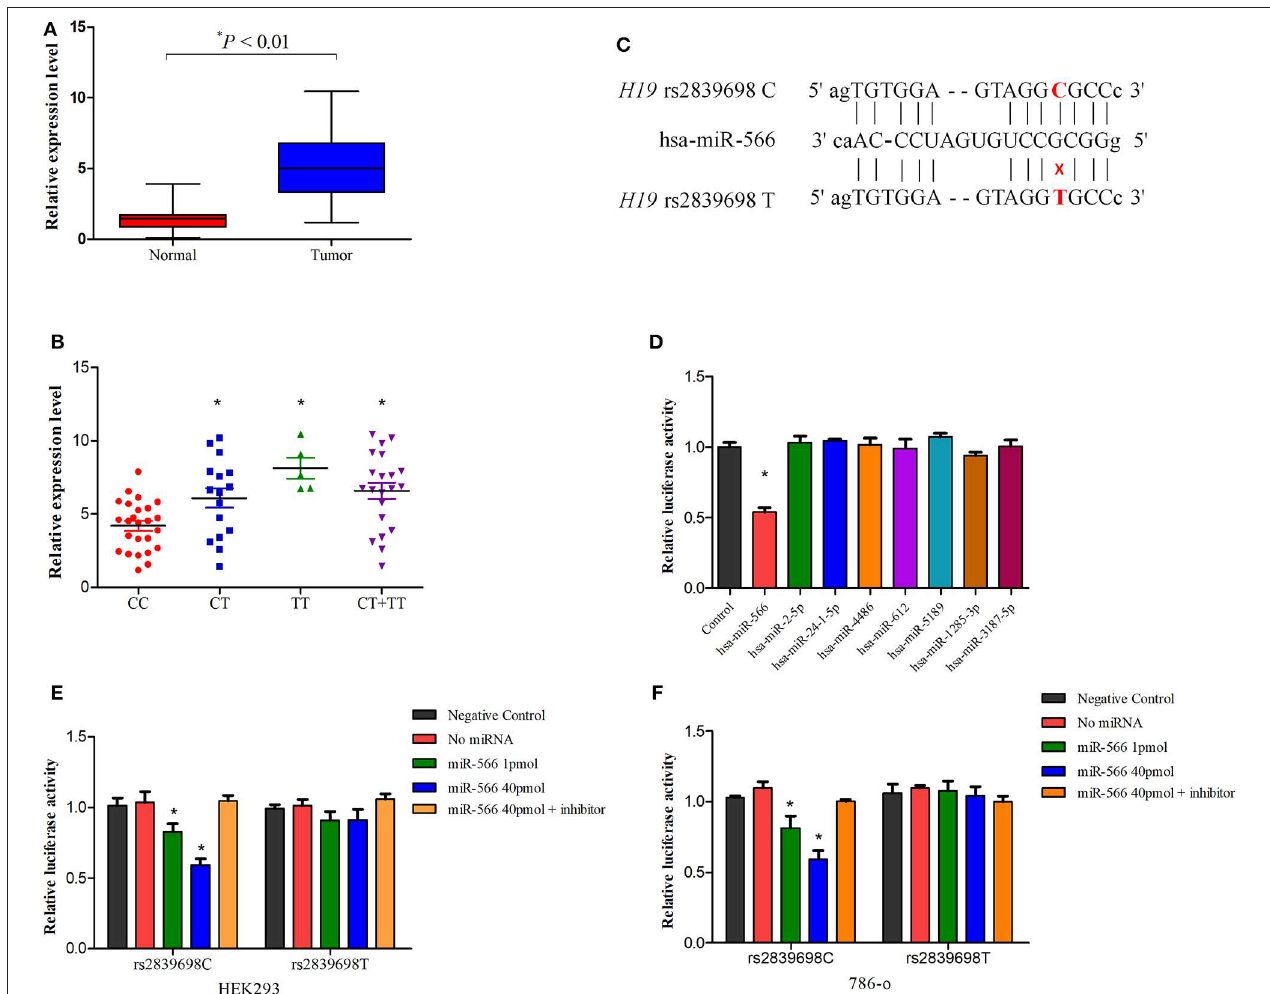
FIGURE 2 | The influence of H19 rs2839698 variant on H19 expression. (A) Distribution and comparison of H19 expression in tumors and adjacent normal tissues ( P < 0.01); (B) Association between the H19 expression in renal tissues and H19 rs2839698 genotypes ( P = 0.019, 0.004, and 0.001 for CT vs. CC, TT vs. CC and CT/TT vs. CC, respectively); (C) Schematic image of binding interaction between miR-566 and H19 rs2839698C and T alleles. (D) The psi-CHECK-2-H19-C-allele and miRNA mimics were co-transfected into HEK293 cell line. Relative luciferase activities in the cells were measured from three independently differentiated clones